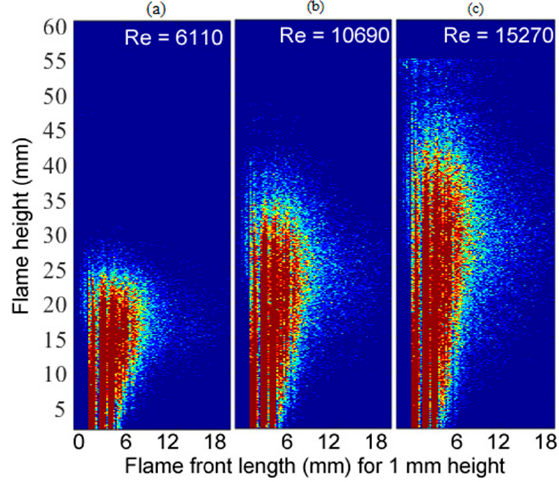
Figure 12. Wrinkled rate under different flame heights with nitrogen dilution volumetric proportion of 10%, hydrogen proportion of 50%, different Reynolds number: ( a ) Re = 6110; ( b ) Re = 10,690; ( c ) Re = 15,270.